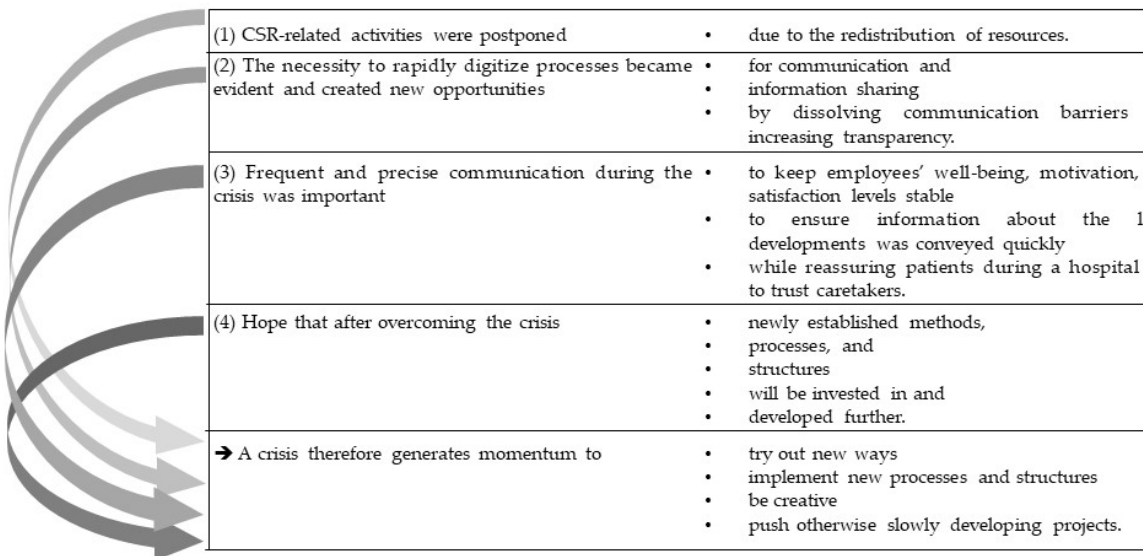
Figure 3. Aggregated research findings. Content was revealed by means of a qualitative text analysis process [104] employing